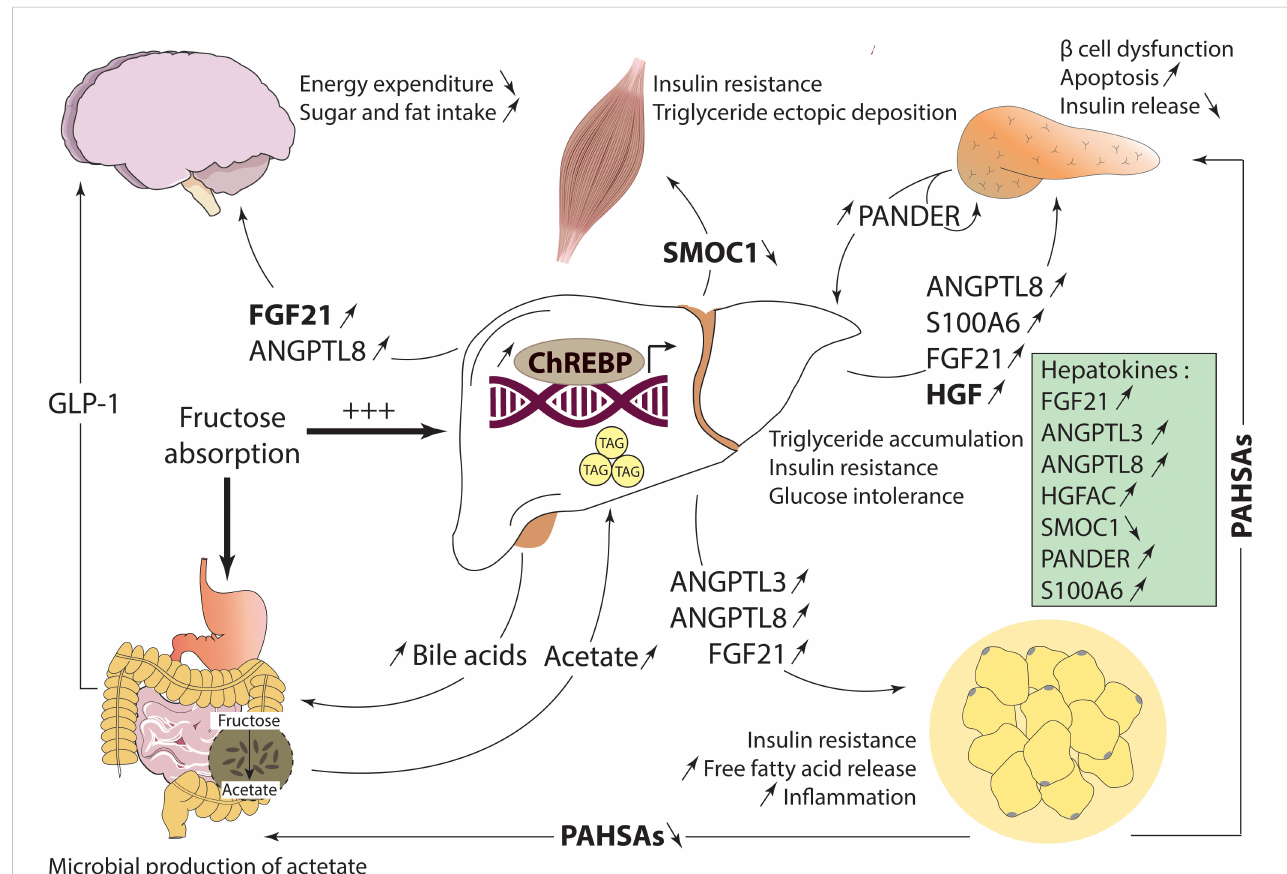
FIGURE 2 In disease, signaling factors levels are dysregulated due to altered activity of ChREBP. In the liver, ChREBP contributes to hepatic steatosis through direct stimulation of the lipogenic pathway. This is more notable in the case of fructose overconsumption, which accelerates the process via direct metabolization in the liver and acetate formation, a lipogenic substrate, by the microbiota in the intestine. At the periphery, ChREBP modulates the alteration in bile acids levels and composition, impairing dietary lipids absorption and GLP-1 secretion. Changes in ChREBP-dependent hepatokines levels are strongly associated to hepatic and systemic insulin resistance. Finally, in adipocytes, PAHSA secretion is decreased due to decreased ChREBP activity, which contributes to the insulin resistant state and disease